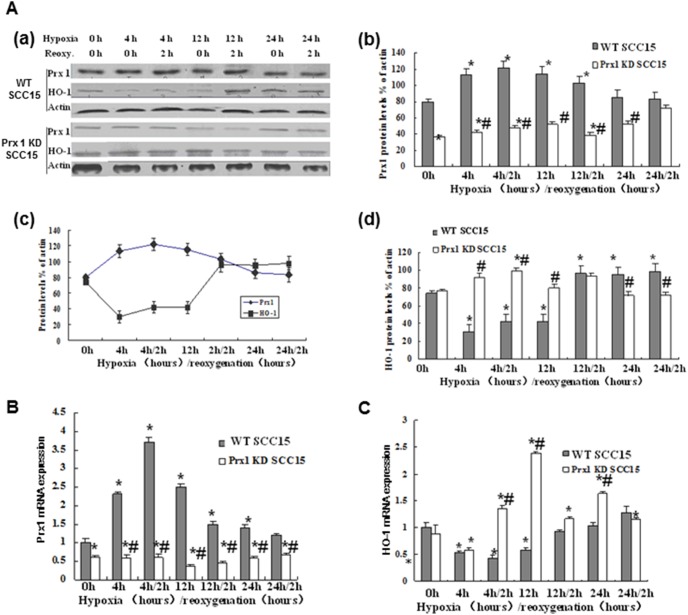
Expression of Prx1 and HO-1 in SCC15 cells.A (a), protein expression of Prx-1 and HO-1 detected by Western blot after hypoxia/reoxygenation treatment; A (b and d), Prx1 and HO-1 protein quantitation relative to β-actin; A (c), correlation of Prx-1 and HO-1 after hypoxia/reoxygenation treatment. B and C, mRNA expression of Prx-1 and HO-1 detected by qRT-PCR after hypoxia/reoxygenation treatment. *P<0.05 vs. WT SCC15 cells; #
P<0.05 vs. control hypoxic WT SCC15 cells.